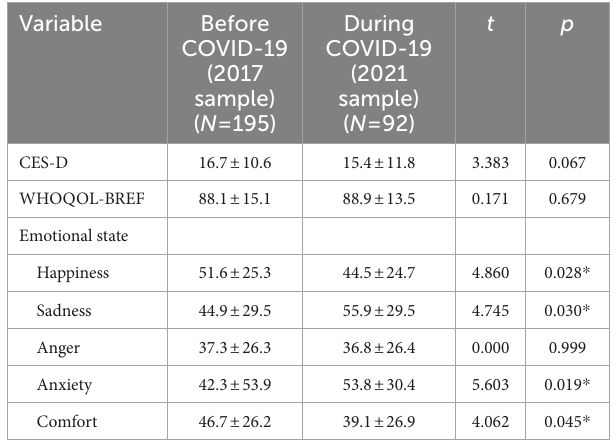
TABLE 2 Subjective measures of mood and well-being by family caregivers of ICU